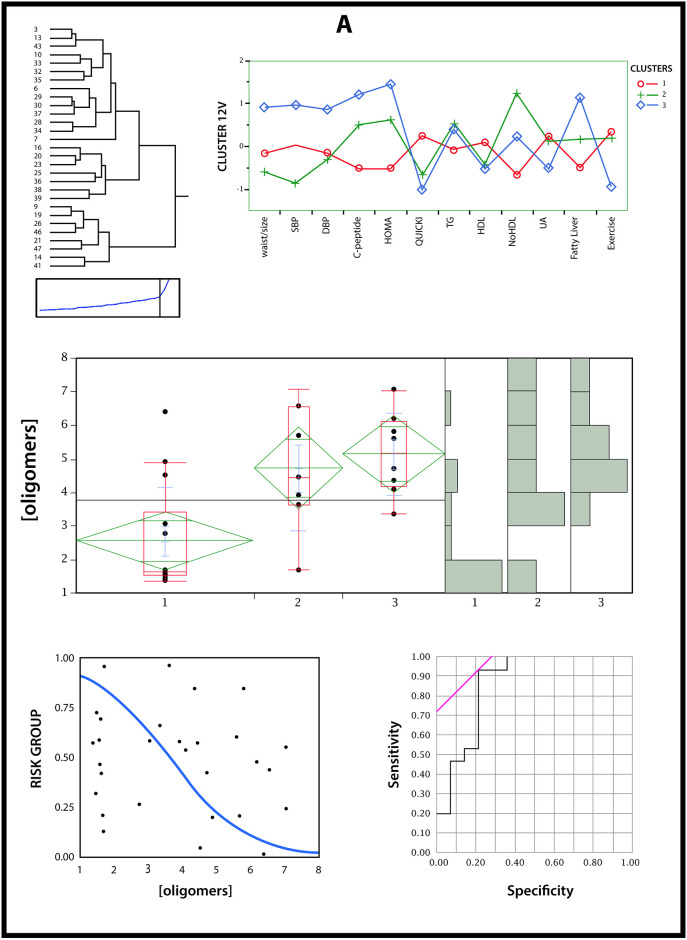
Data-driven cluster analysis to identify cases with a high risk of beta cell damage.A cluster analysis of several variables that were related to beta cell state was performed for patients with obesity (12 variables); by means of a cluster analysis, 3 subgroups were obtained whose profiles can be typified as “healthy” obesity, gynecoid obesity, and android obesity. The ROC curve for patients with obesity displays a sensitivity of 0.93 and specificity of 0.79. Lower RIAO values (< 3.35 μg/ml) suggest integrity of beta cell functions (p < 0.001). The cut point expresses the increase in risk [OR de 51.32 [4.67–564.16] p = 0.001] for children with a positive result in comparison to those with a negative result (<3.35 μg/ml).